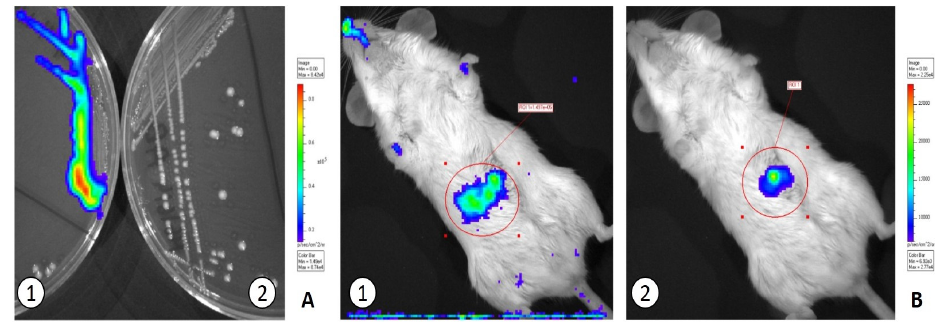
Figure 2. In vitro and in vivo detection of L. lactis MG1614 transformed with pMG36:: luxABCDE . ( A ) GM17 agar plate with transformed (left) and non ‐ transformed (right) L. lactis MG1614 cells. ( B ) Mouse immediately (left) and 20 min (right) after being fed with L. lactis pMG36e:: luxABCDE .